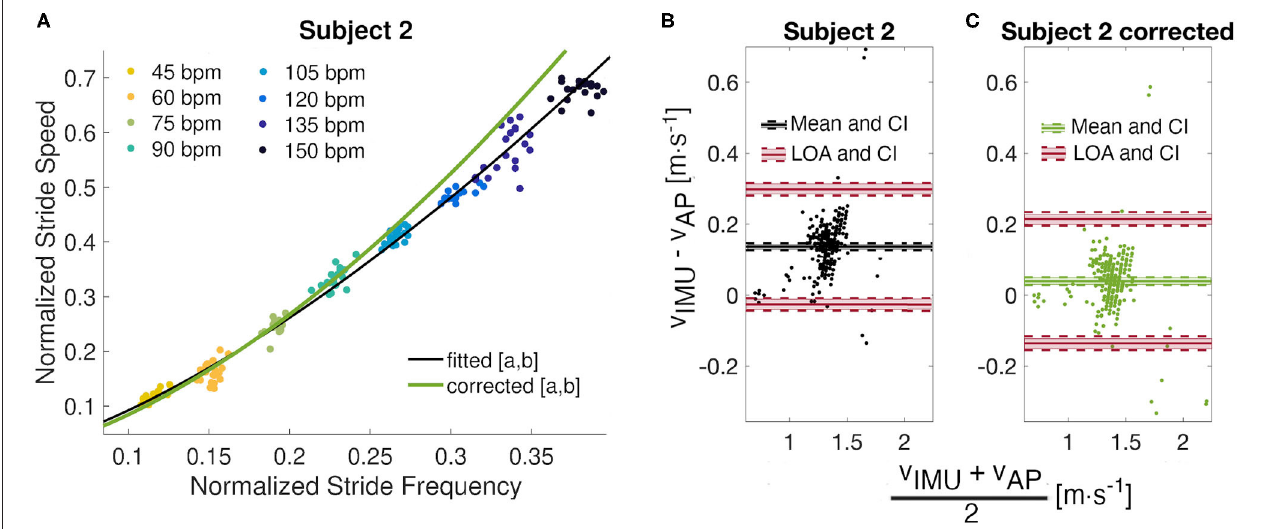
FIGURE 5 | Model correction. (A) Observation of the metronome walk fitted curve ( a = 2.050 and b = 0.335) against the corrected power model ( a ′ = 2.266 and b ′ = 0.399) for Subject 2. (B) Bland Altman analyses for the original and (C) corrected models with mean differences, limits of agreements, and their confidence intervals